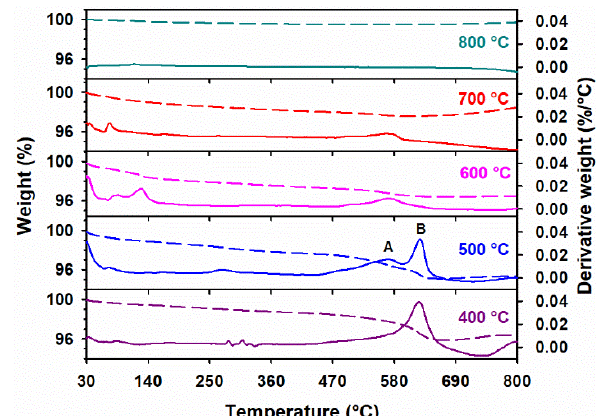
Figure 3. Thermogravimetric analysis (TGA, dashed line with the left vertical axis) and the first derivative of the thermogram (solid line with the right vertical axis) curves for 100 Fe:5 K material, at the calcination temperatures indicated in each panel. Peaks A and B correspond to the conversion of KNO 2 to K 2 O, and of KNO 3 to KNO 2 , respectively.